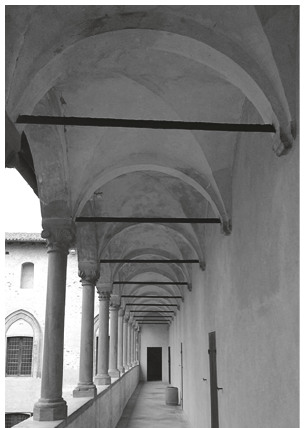
Figure 1: Tie-rods in the Castle of Torrechiara in Langhirano, Parma,